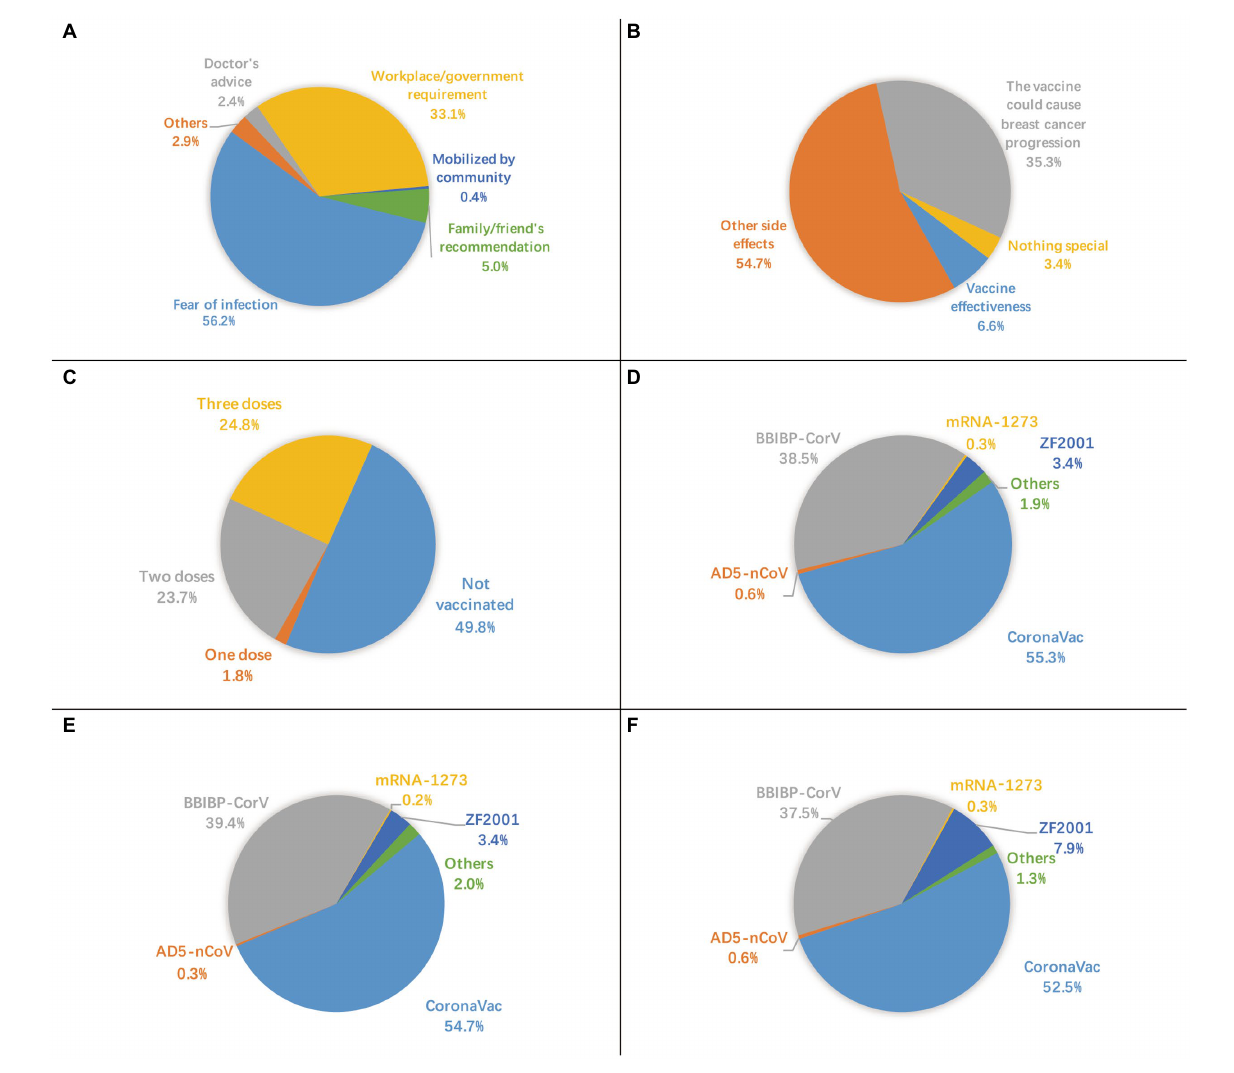
FIGURE 2 (A) main reason for vaccination, (B) main concern before vaccination, C status of vaccination, D type of first vaccine dose, E type of second vaccine dose, F type of third vaccine